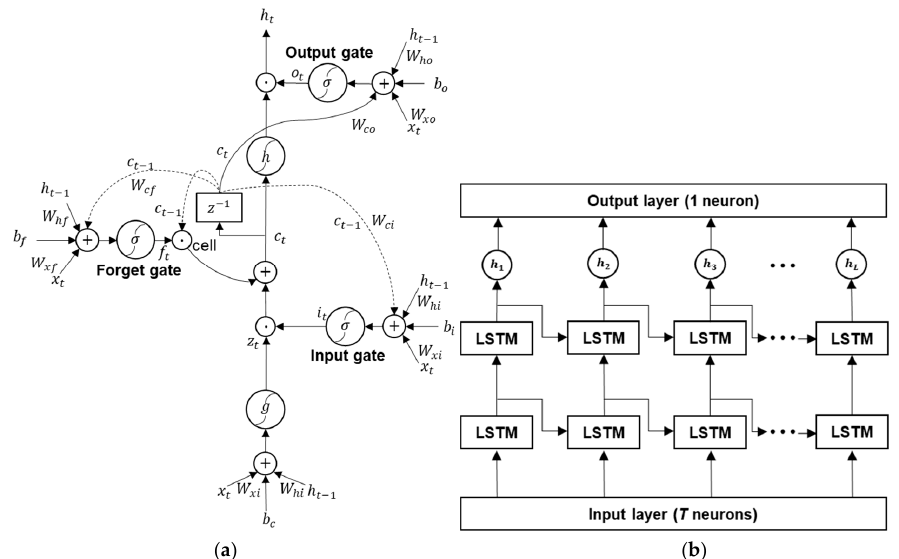
Figure 3. ( a ) A Long Short-Term Memory (LSTM) memory block with an input, a forget, and an output gate, and ( b ) the architecture of a conventional LSTM neural network with a T -dimensional input vector and L hidden